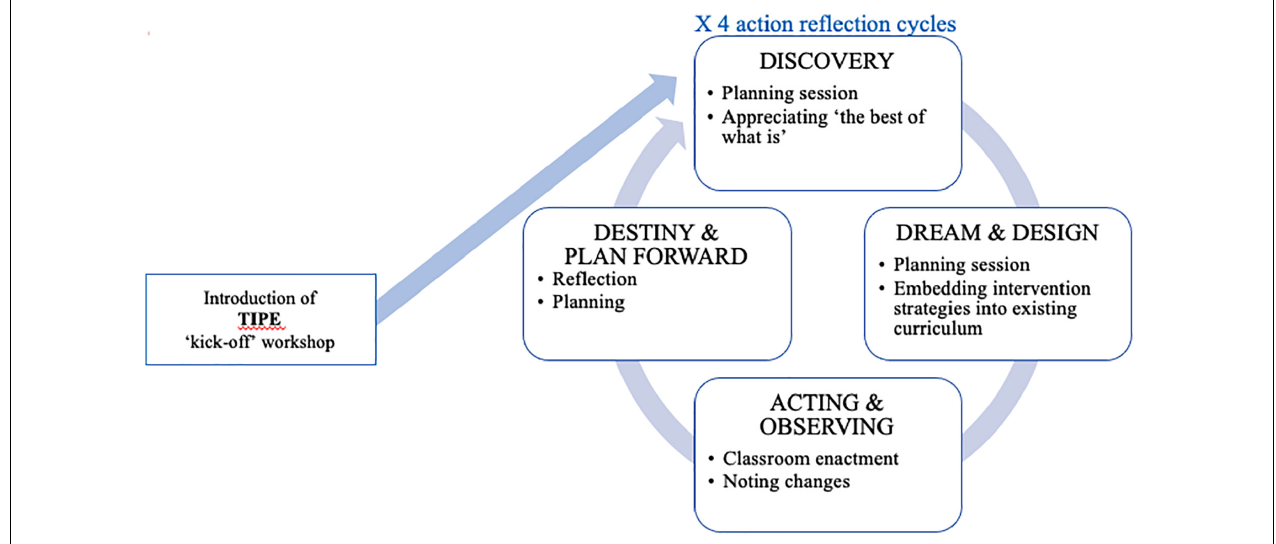
FIGURE 1 | TIPE appreciative inquiry participatory action research cycle (adapted from Brunzell, 2019, p. 33).